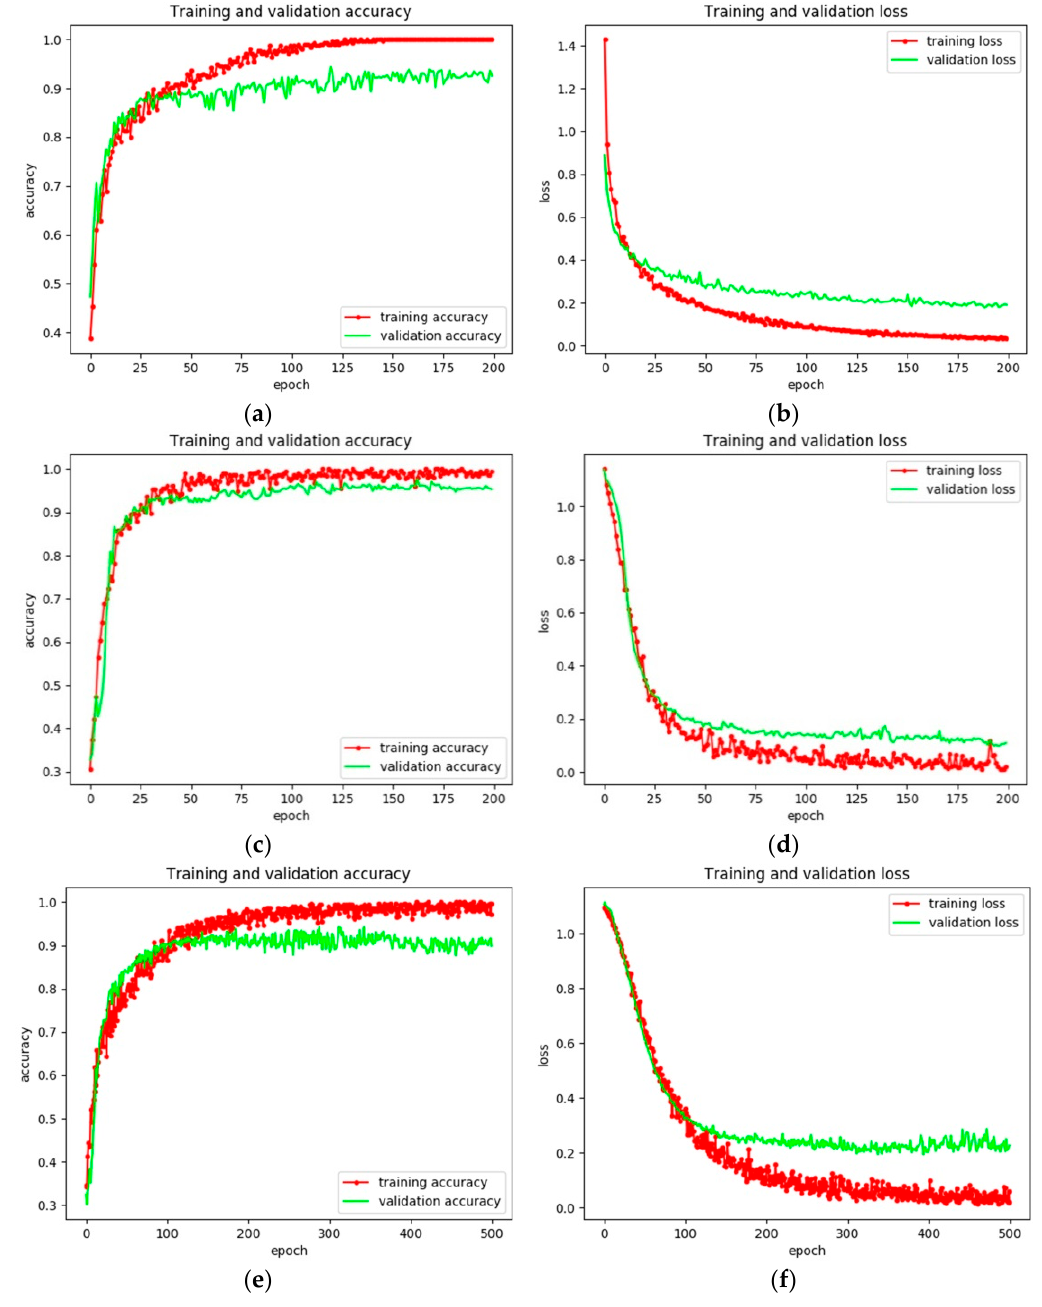
Figure 10. Training and validation accuracies of the ship classification model based on Xception. ( a , c , e ) show the training and validation accuracies, and ( b , d , f ) show the corresponding training and validation losses via the VGG19, InceptionV3, and Xception models, respectively. Table 8. Classification accuracies and training time of the four